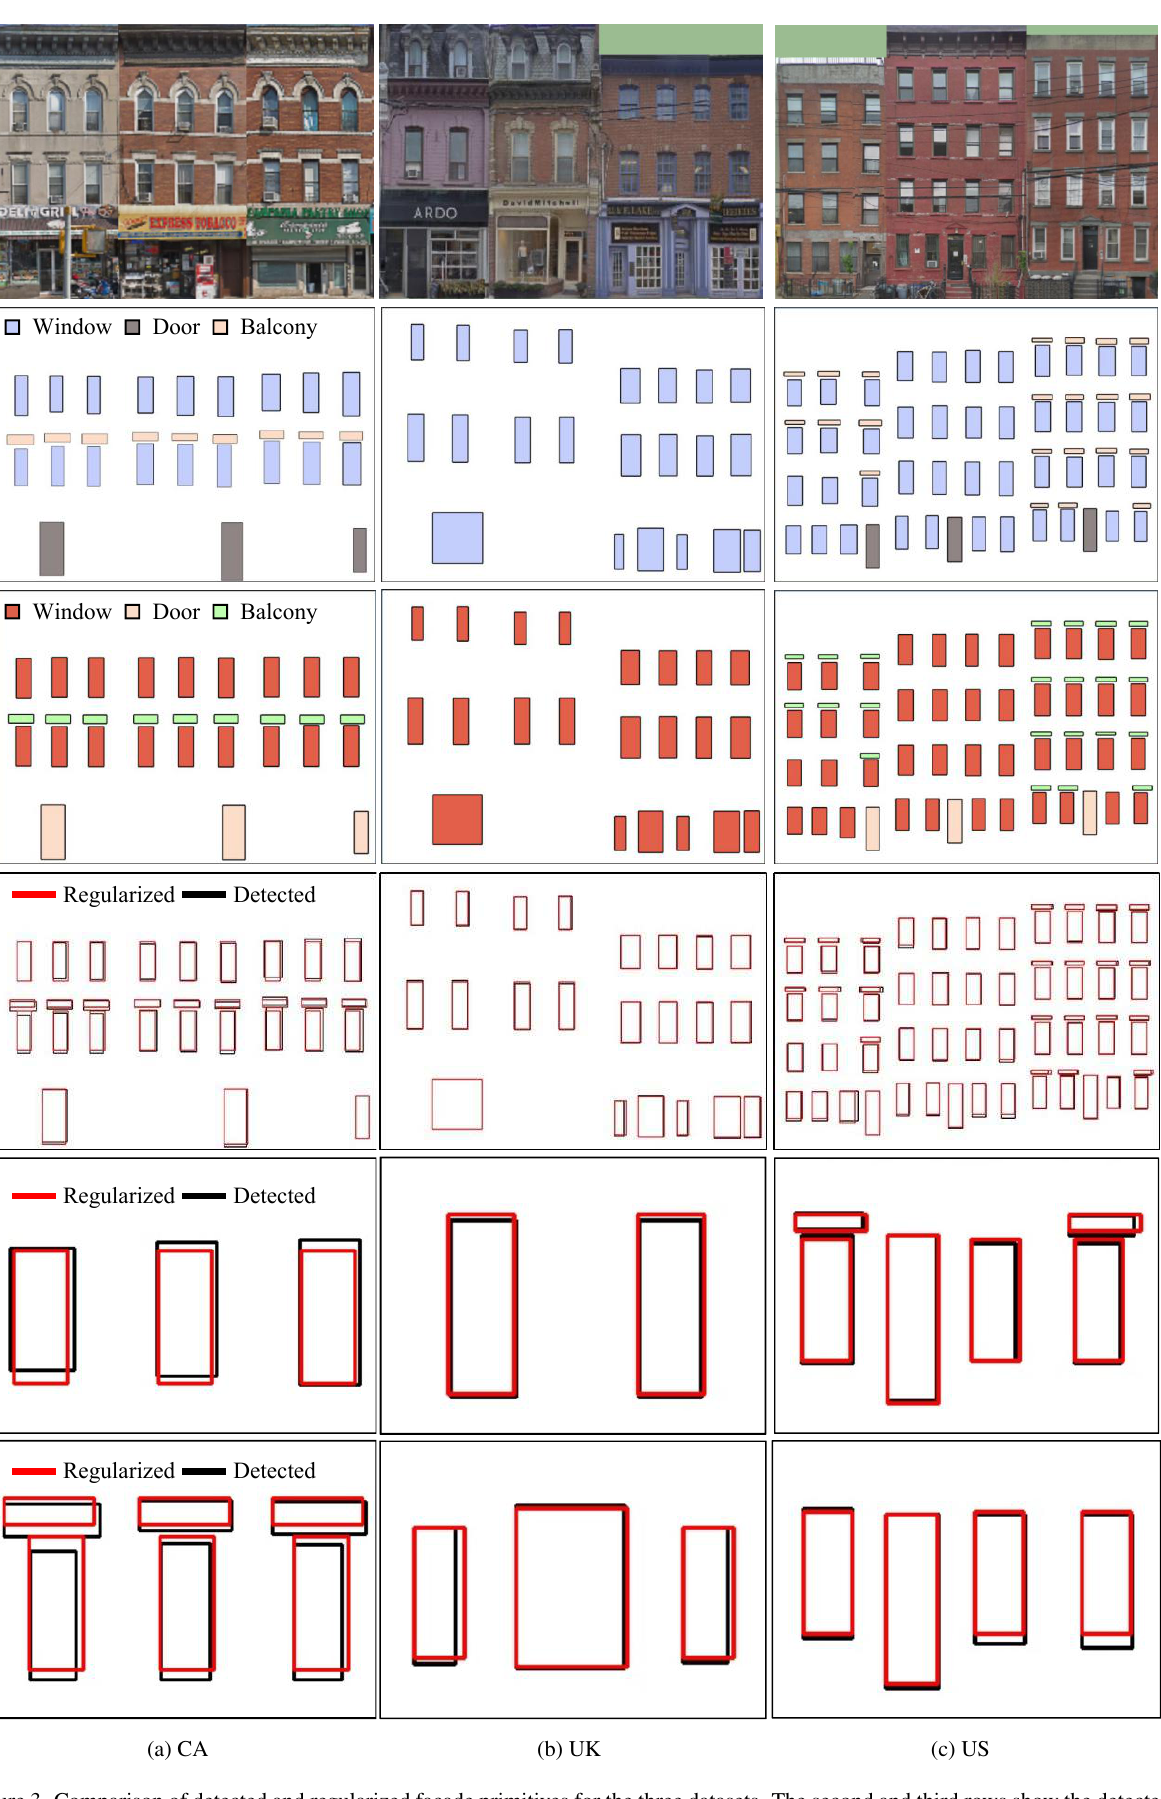
Figure 3. Comparison of detected and regularized fac¸ade primitives for the three datasets. The second and third rows show the detected and regularized primitives, respectively. The fourth row compares them and the last two rows give two enlarged